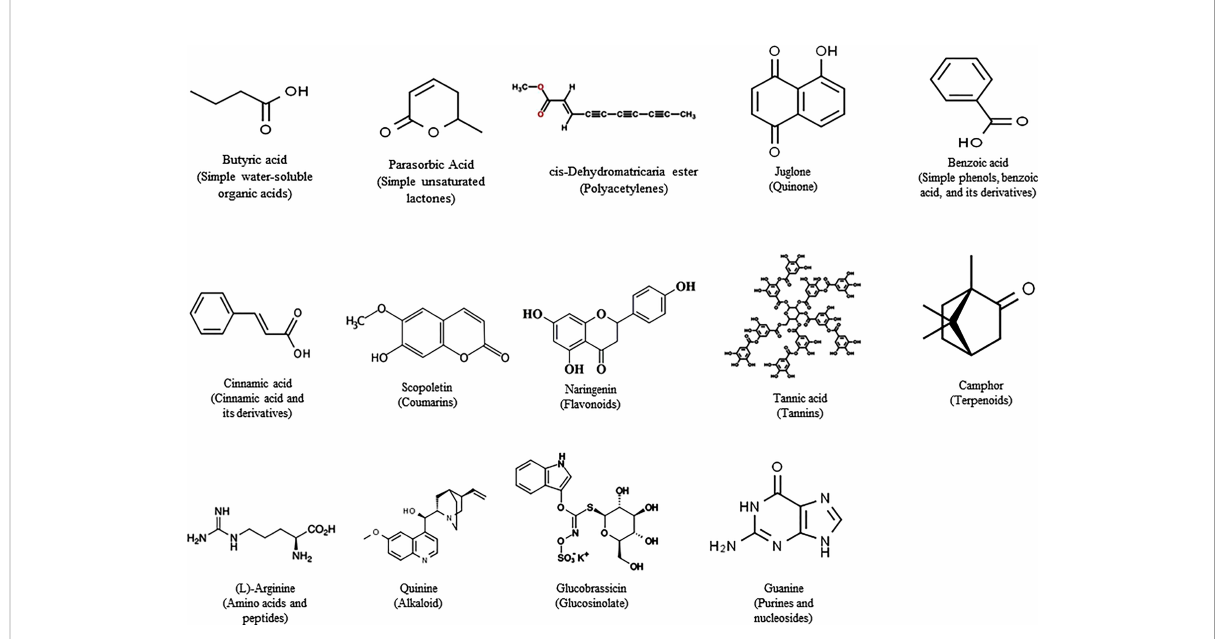
FIGURE 1 Representive allelochemicals from the classi fi ed 14 categories based on their chemical